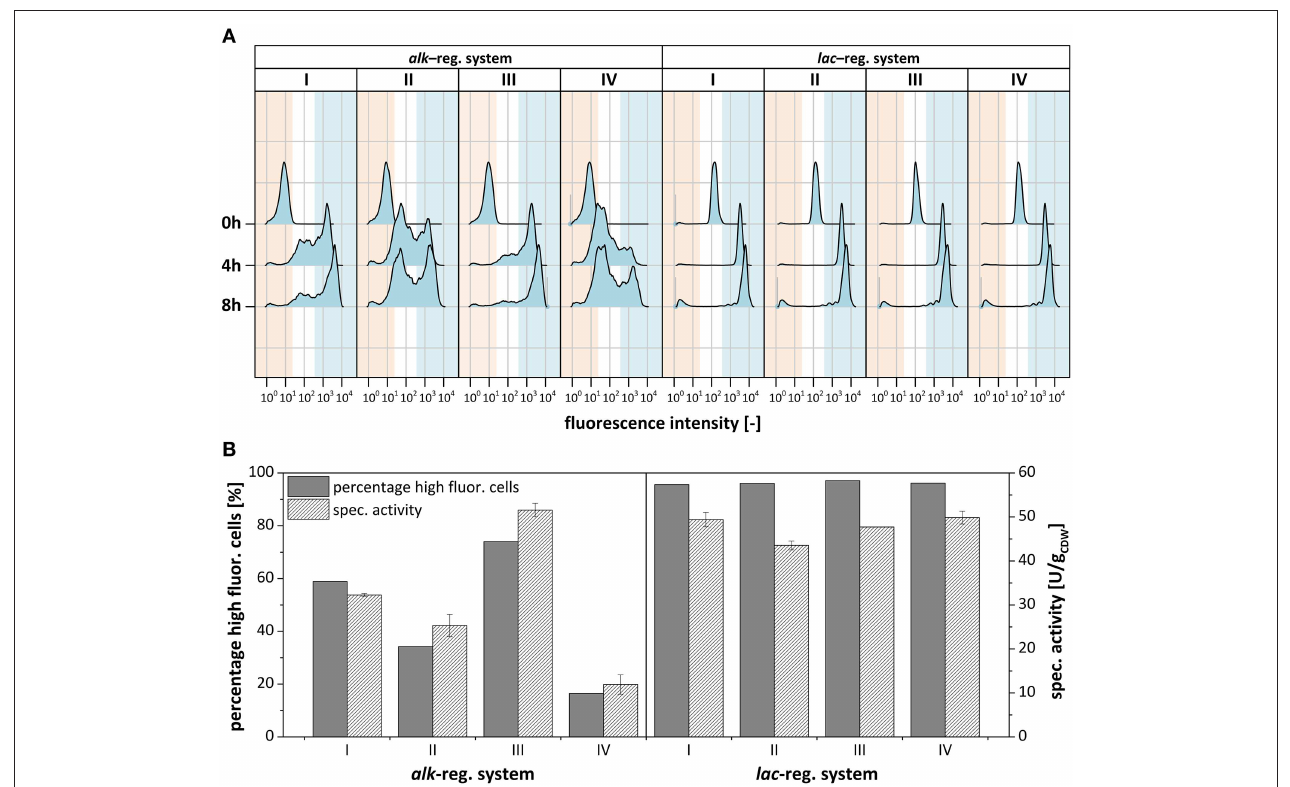
FIGURE 5 | Subpopulation formation of recombinant P. putida DOT-T1E regarding styA-eGFP expression determined via flow cytometry. (A) Flow cytometry analysis of cultures visualized in Figure 4 expressing the fusion construct styA-eGFP under control of the alk - (left) and the lac -regulatory systems (right) before, 4h after, and 8h after induction. Populations are split into non-fluorescing (red), low- to medium-fluorescing (white) and high-fluorescing (blue) subpopulations. (B) Bar chart correlating the percentage of cells showing high eGFP fluorescence and respective specific styrene epoxidation activities of the whole population after 4h of induction.